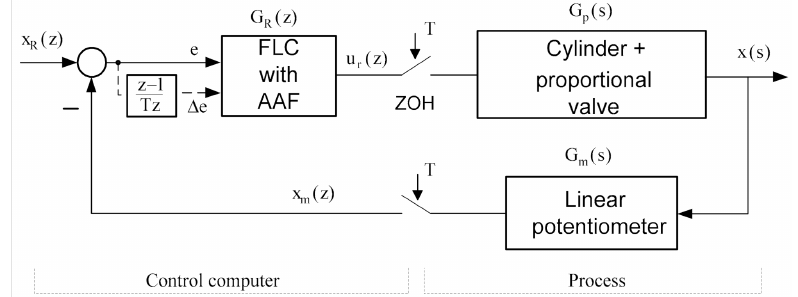
Figure 4. Block diagram representation of the pneumatic servo